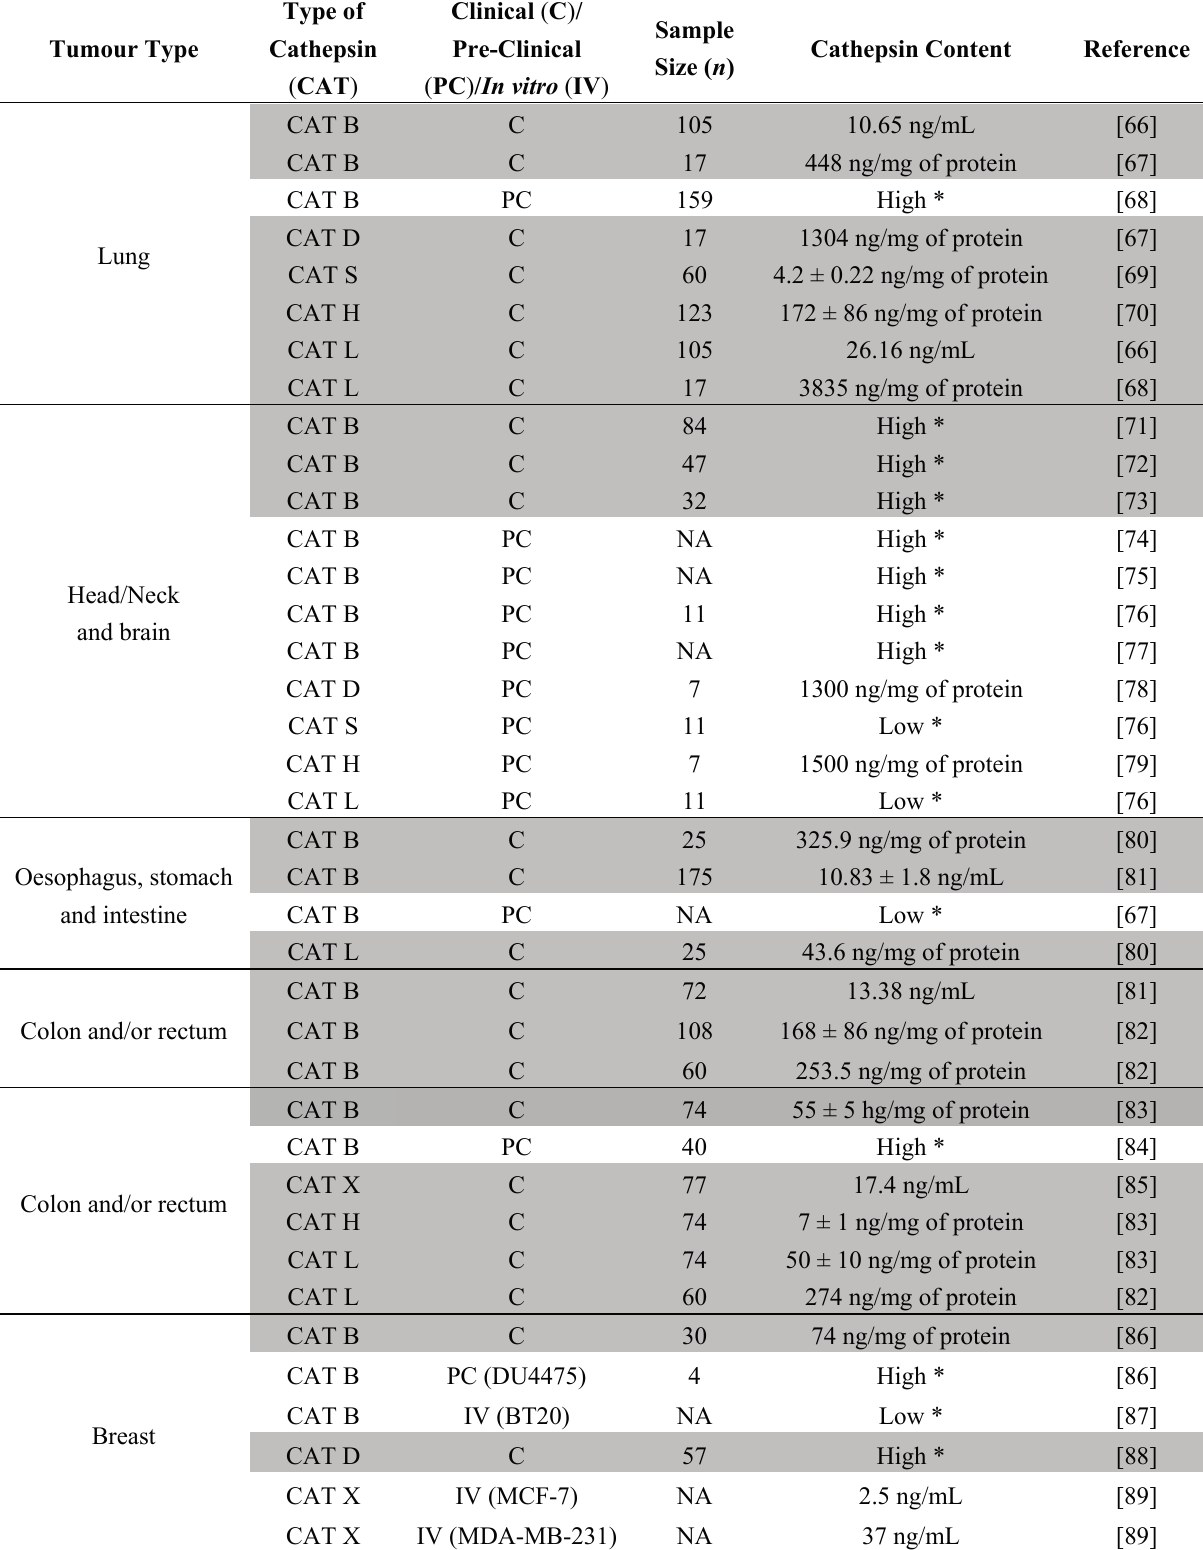
Table 6. Cathepsin levels found in clinical and preclinical sample of different tumour types (clinical studies highlighted in